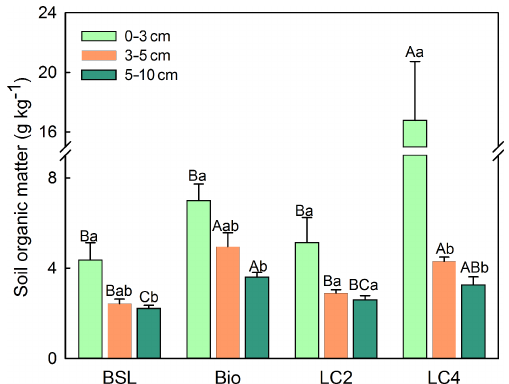
Figure 2. Soil organic matter content (0–10cm soil depth) in bare sandy land and different crust soils (M ± SE). Note: BSL, bare sandy land; Bio, moss crust; LC2, litter crust for 2 years; LC4, litter crust for 4 years. Different uppercase letters indicate significant dif- ferences among the various crust soils in the same soil layer at the level of p< 0 . 05, and different lowercase letters indicate significant differences among the different soil layers at the level of p< 0 .